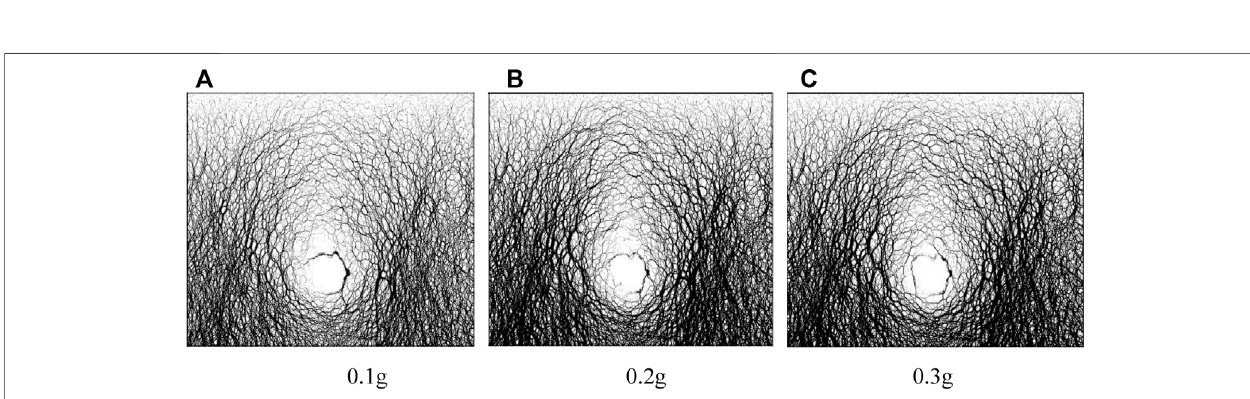
FIGURE 9 | Force chain patterns of circular tunnels under earthquake of various amplitudes. (A) 0.1 g. (B) 0.2 g. (C) 0.3 g.